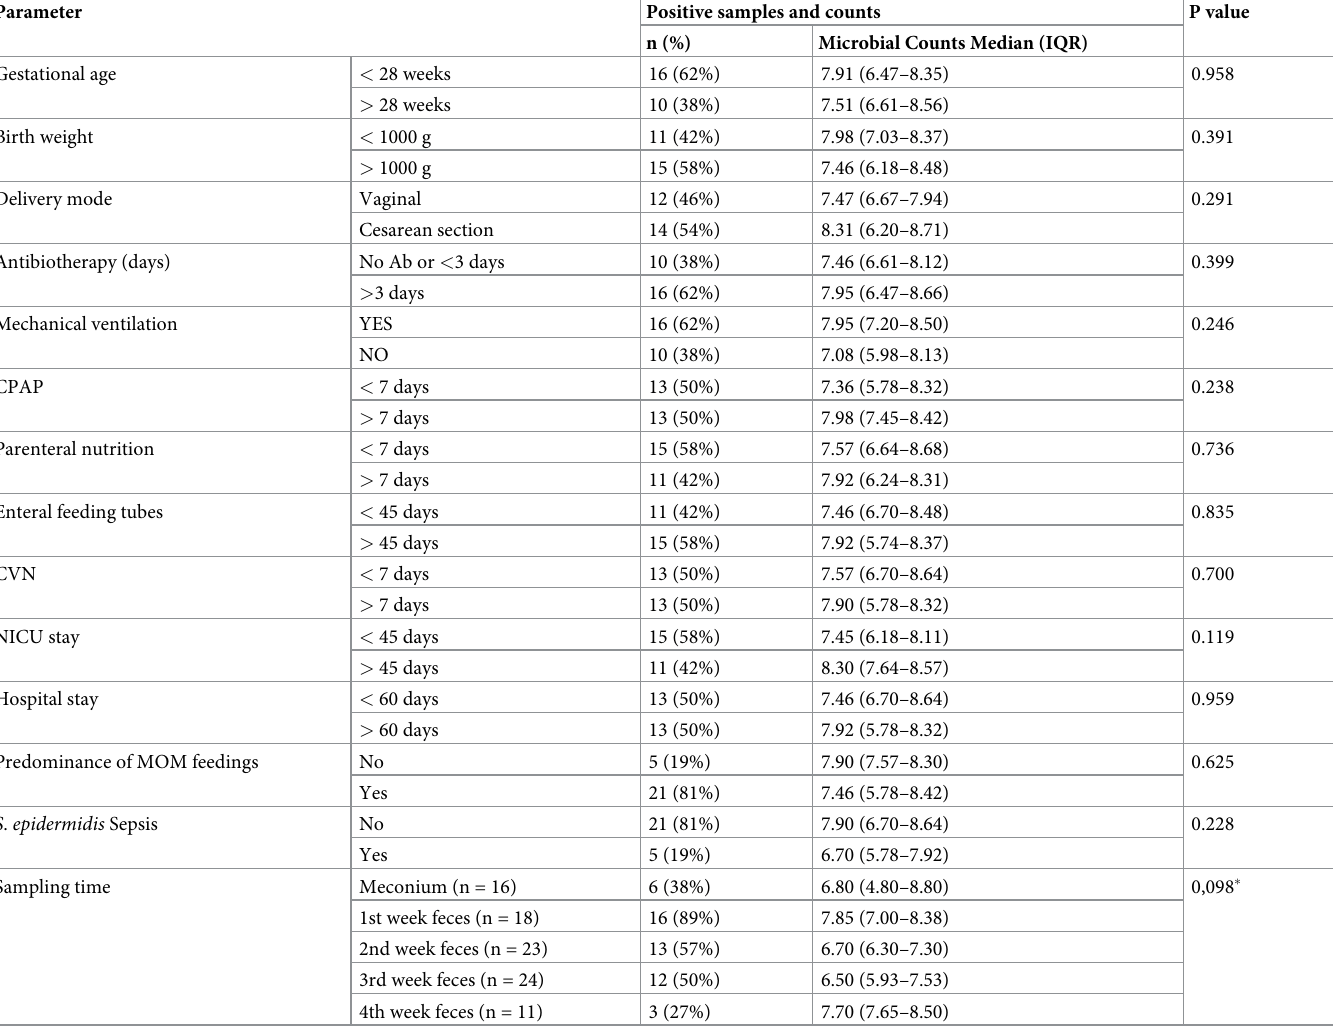
Table 3. Relationships between S . epidermidis colonization (counts expressed as log 10 CFU/g) and the main clinical and demographic data.